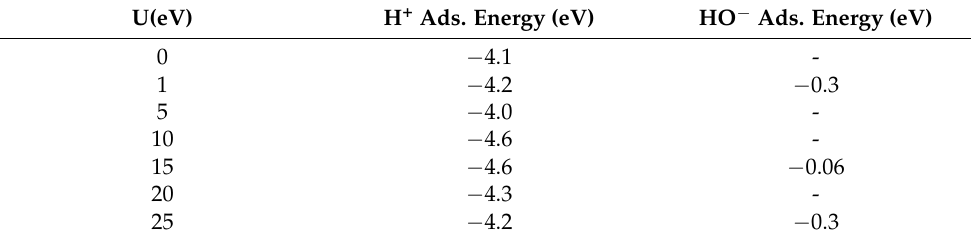
Table 4. (H + , HO − ) Adsorption energies inside (16,0) CNT. U(eV) H + Ads. Energy (eV) HO − Ads. Energy